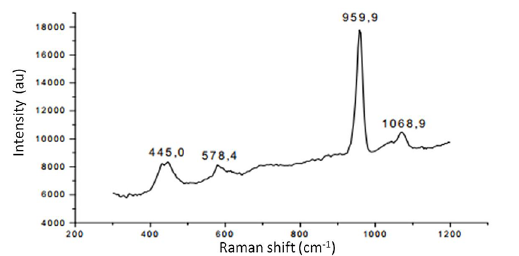
Figure 4. Raman spectra of hydroxyapatite before CaP coating (A). Broad bands are due to the overlapping of the optical window signal.